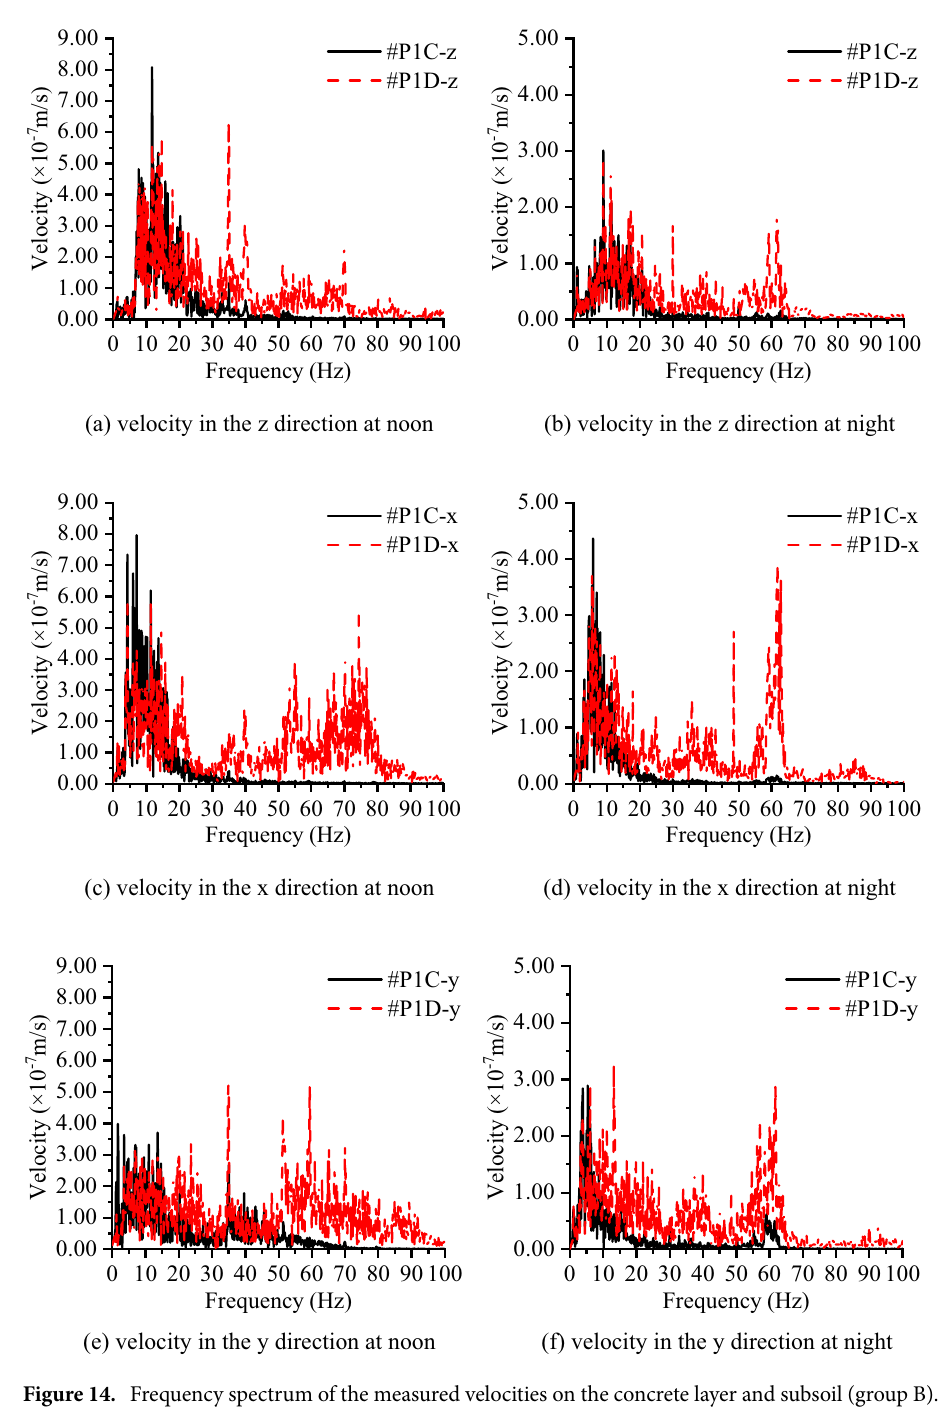
Figure 14. Frequency spectrum of the measured velocities on the concrete layer and subsoil (group